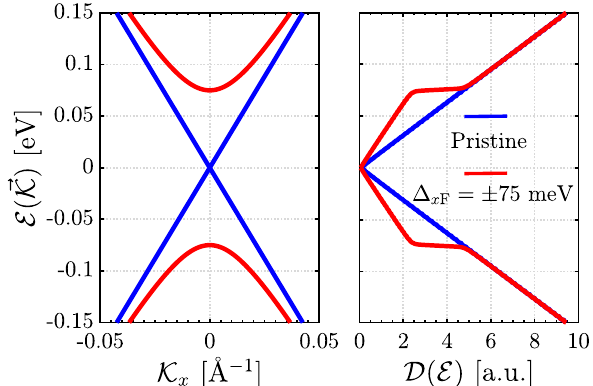
Figure 3. Two-band energy spectrum (left panel) and DOS of TCIs (right panel) in the absence and presence 75 meV. The distortion is applied along one direction only making two of an arbitrary ferroelectric gap (cid:31) x F = ± Dirac cones gapped and keeps two rest ones gapless in the SBZ. The total DOS of all these gapless and gapped Dirac cones are plotted in the right